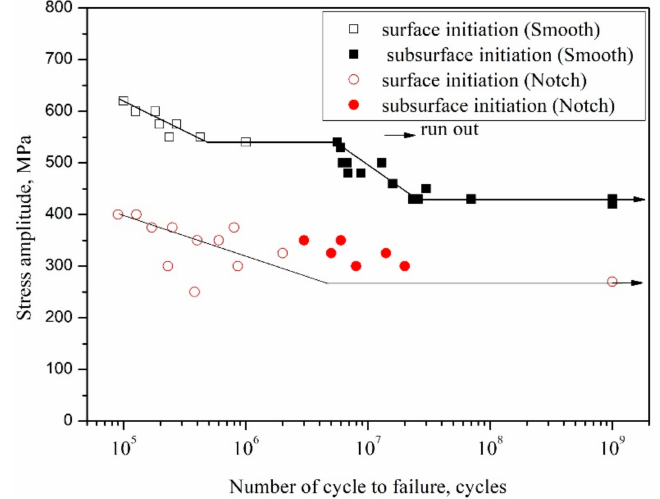
Figure 5. S–N curves for smooth and notched specimens of TC21 titanium alloys (arrows denote the run-out